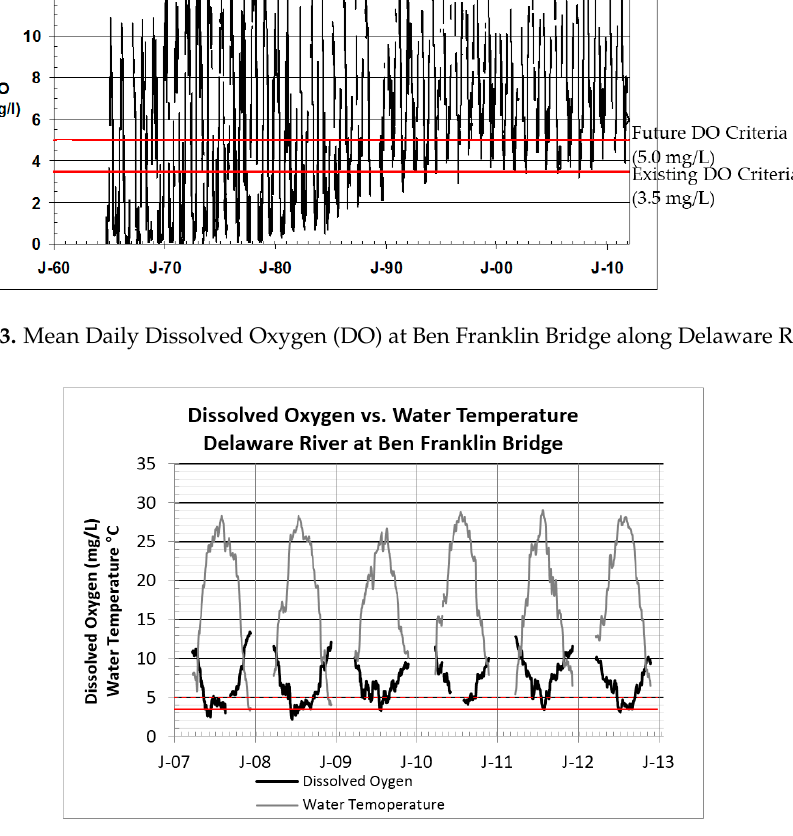
Figure 4. Water temperature/dissolved oxygen along the Delaware River.